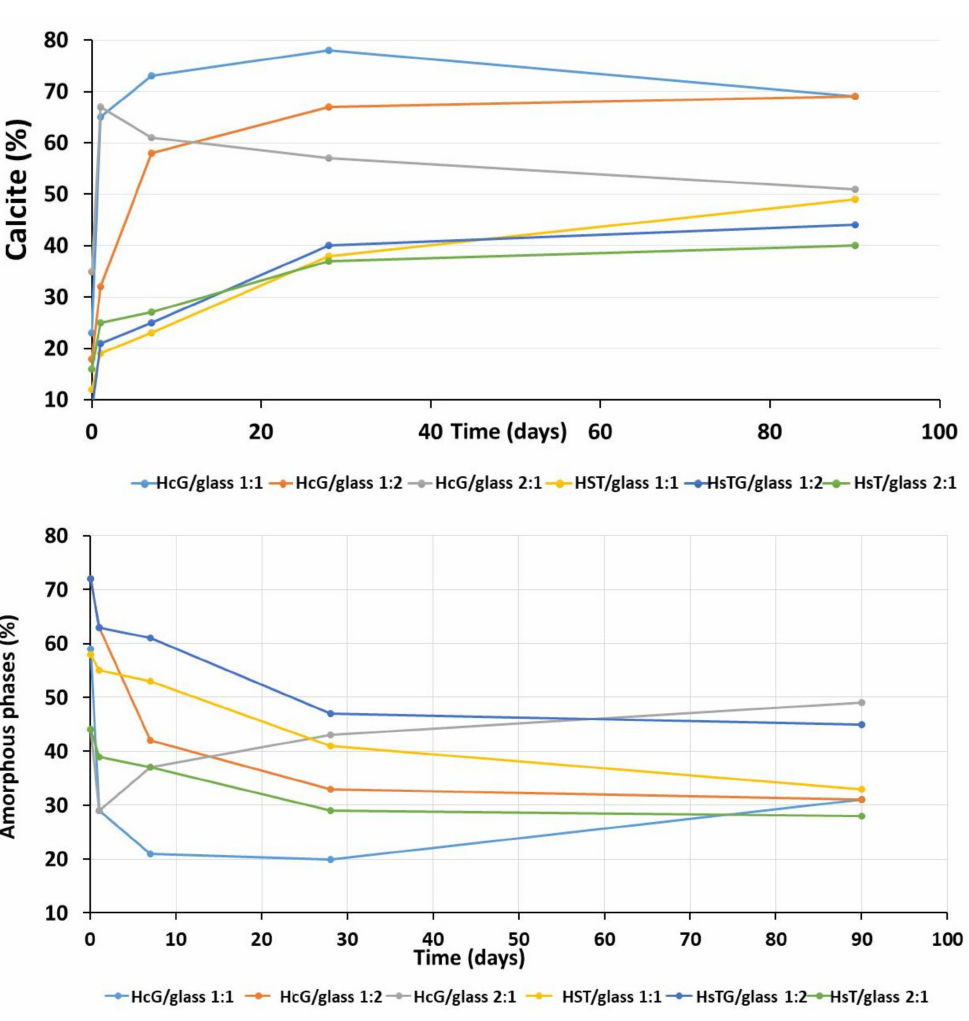
Figure 12. Calcite ( up ) and amorphous phases ( down ) evolution up to 90 days of reaction. This process occurs in calcareous mix (HcG/glass) between 1 and 7 days, but in siliceous mix (HsT/glass) it lasts up to 90 days (Figure